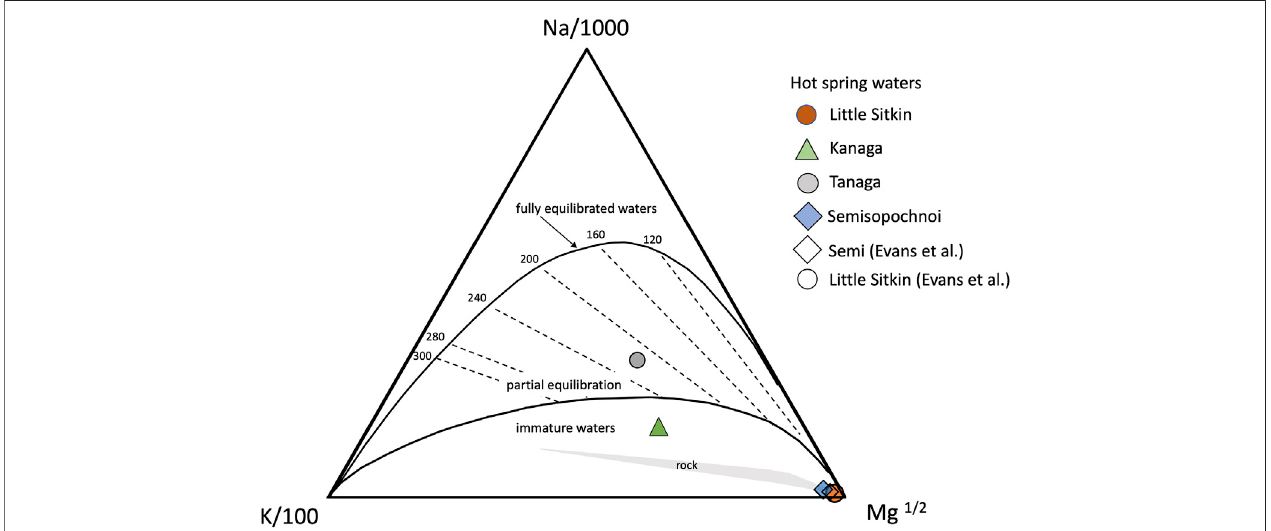
FIGURE 11 | Diagram showing the relative abundances of Na, K and Mg with lines indicating the compositions of waters partially or fully equilibrated with typical rockalterationmineralassemblagesatthegiventemperatures(Giggenbach,1988).Alsoshownisthe fi eldforatypicalrockcomposition.Oursamplesaredominatedby compositions that re fl ect immature waters not yet equilibrated with these mineral assemblages.